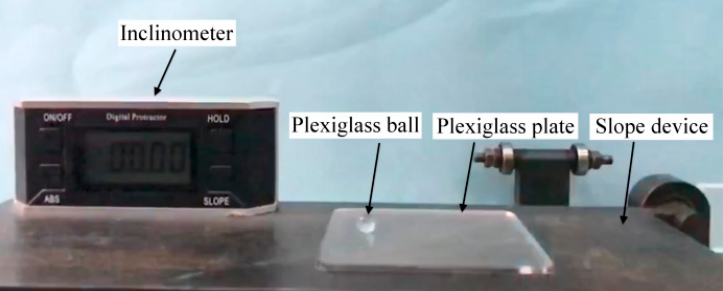
Figure 11. Experimental setup for the coefficient of static friction between boundaries measurement.